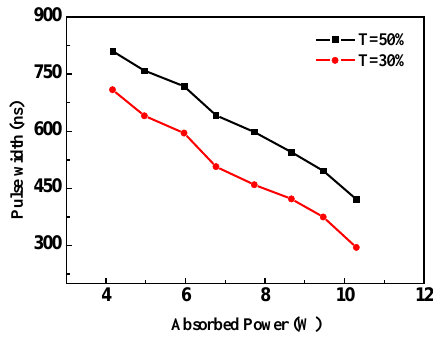
Figure 3. Pulse width, as a function of absorbed pump power.